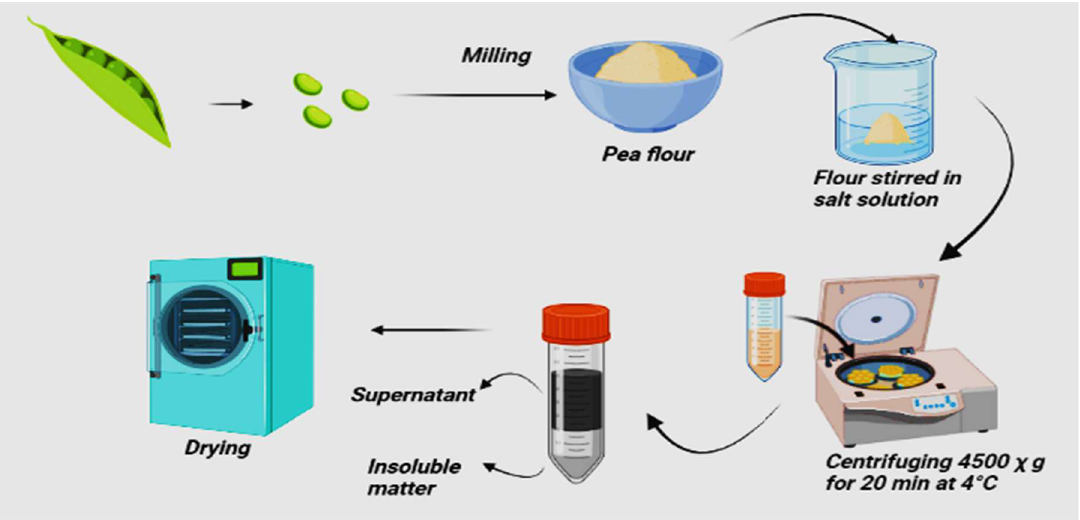
Figure 3. Schematic representation of salt extraction method of protein.